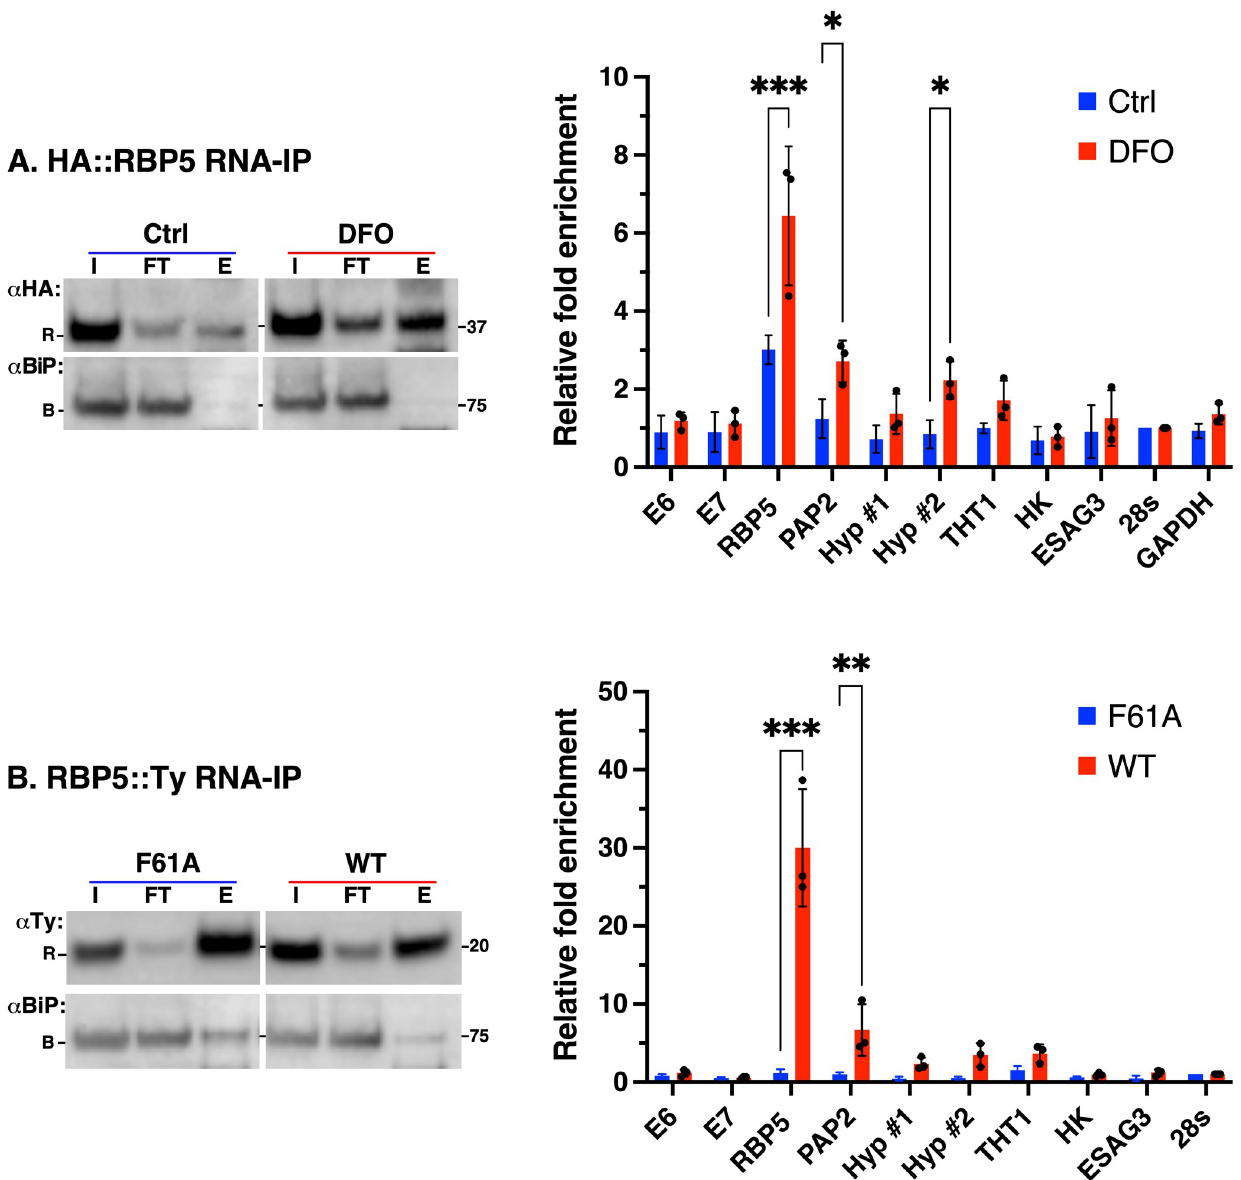
Fig 8. Identification of RBP5-associated mRNAs. A . HA::RBP5 cells were incubated without (Ctrl) or with (DFO) deferoxamine (5 hr) and RBP5 pulldowns were performed with anti-HA beads. Left : Western blot analyses of input (I), flow through (FT) or Eluate (E) fractions with antibodies for HA:: RBP5 ( α HA, R), and BiP ( α BiP, B). Right : RNA was purified from “FT” (input) and “E” (IP) fractions and qRT-PCR performed as described above. Bar chart shows relative fold-enrichment of mRNAs shown on the x-axis as determined by the equation 2 Δ Ct , where Δ C t = C t (input) − C t (IP), C t = cycle threshold, normalised to 28s rRNA as non-bound control. Data are means ± SD ( n = 3 biological replicates: with 2 technical replicates for each n ). ��� P < 0.001, �� P < 0.002, � P < 0.05 as determined by two-way ANOVA with post-hoc Sidak test. Only statistical comparisons with p -values < 0.05 are displayed. All others are not significant. B . C-terminally Ty-tagged wild type RBP5 (WT) or an RRM mutant (F61A) was immunoprecipitated with anti-Ty beads from overexpressing BSF cells simultaneously treated with tetracycline and DFO for 4 hours. Left : RNPs were isolated as described in (a) above and blotted with anti-Ty antibodies for WT or F61A ( α Ty, R) and BiP ( α BiP, B). Right : Bar chart shows relative fold-enrichment of transcripts shown on the x-axis. Fold enrichment and normalisation were performed as in (a). Note: To assess if DFO treatment had an effect on RBP5 mRNA enrichment, the experimental setup was repeated without or with DFO and the data are shown in supplementary S7 Fig.